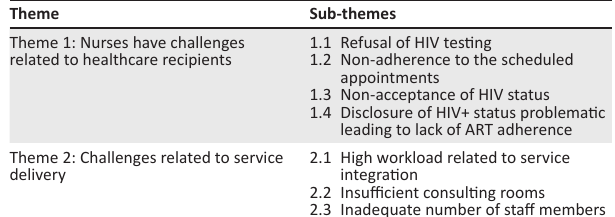
TABLE 1: Themes and